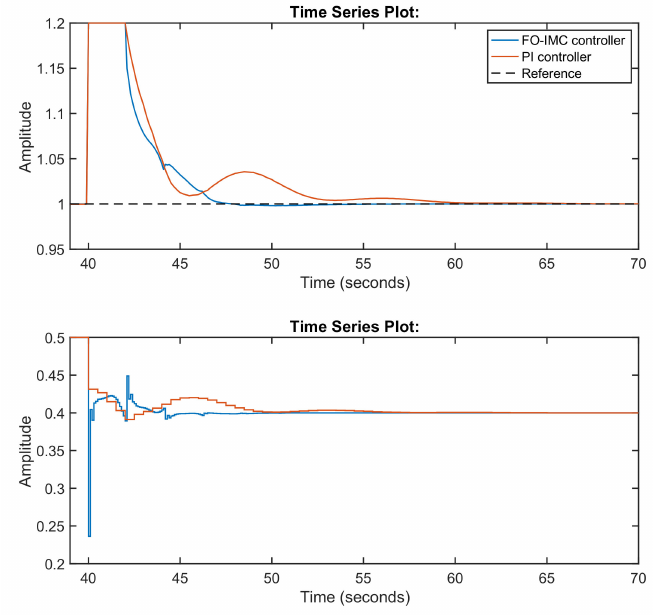
Figure 11. Comparison between the closed loop systems with the event-based FO-IMC and the PI controllers for a 0.2 disturbance rejection (output signal in the upper plot, input signal in the lower